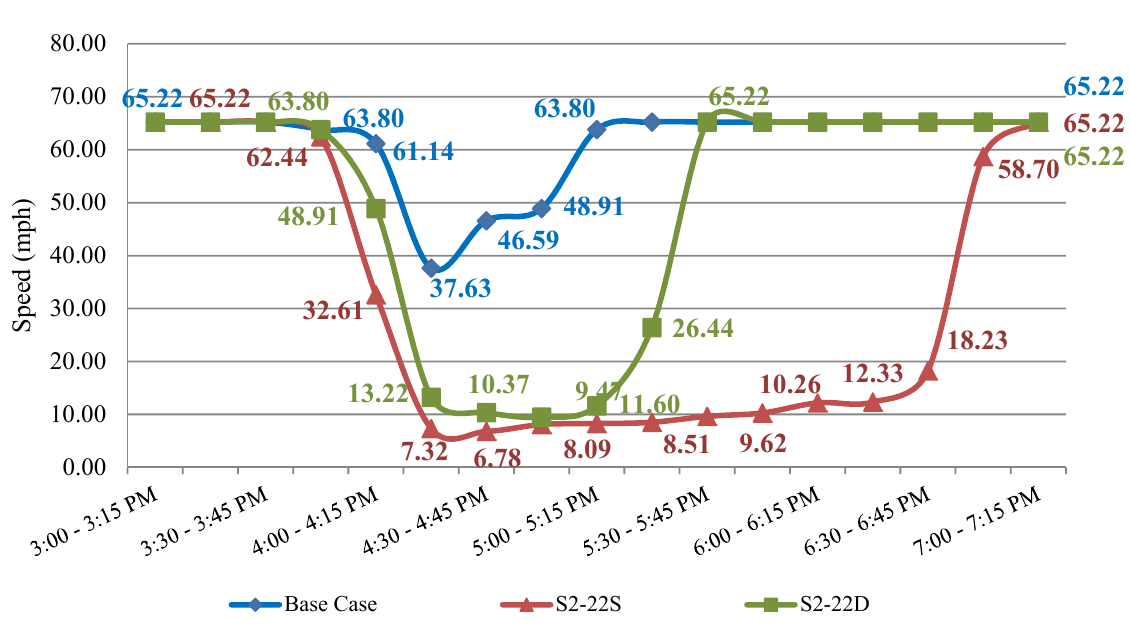
Figure 2. Comparison of base case, S2-22S and S2-22D: Alford Ave.